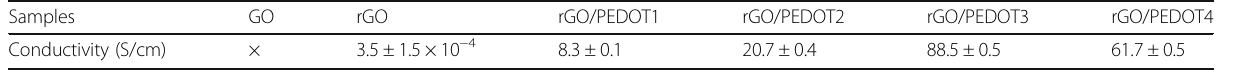
Table 1 Conductivity of GO, hydrothermal-treated GO, and hydrothermal-polymerized rGO/PEDOT